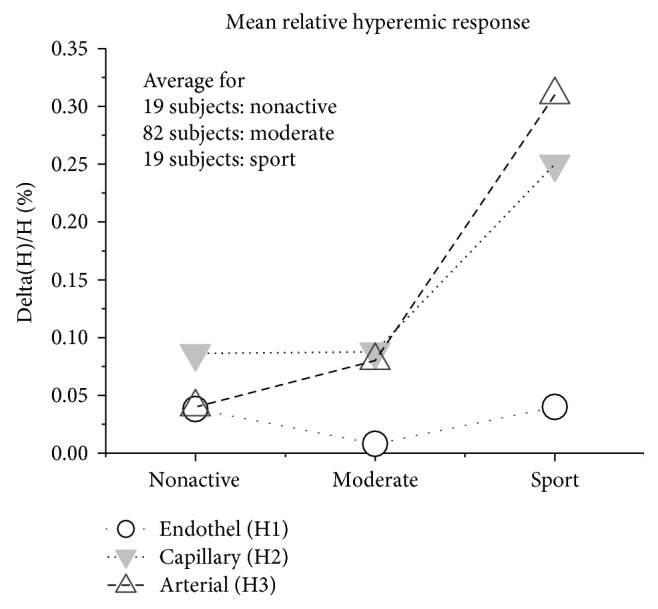
Total perfusion at sessions T1 and T3 versus RHI2.